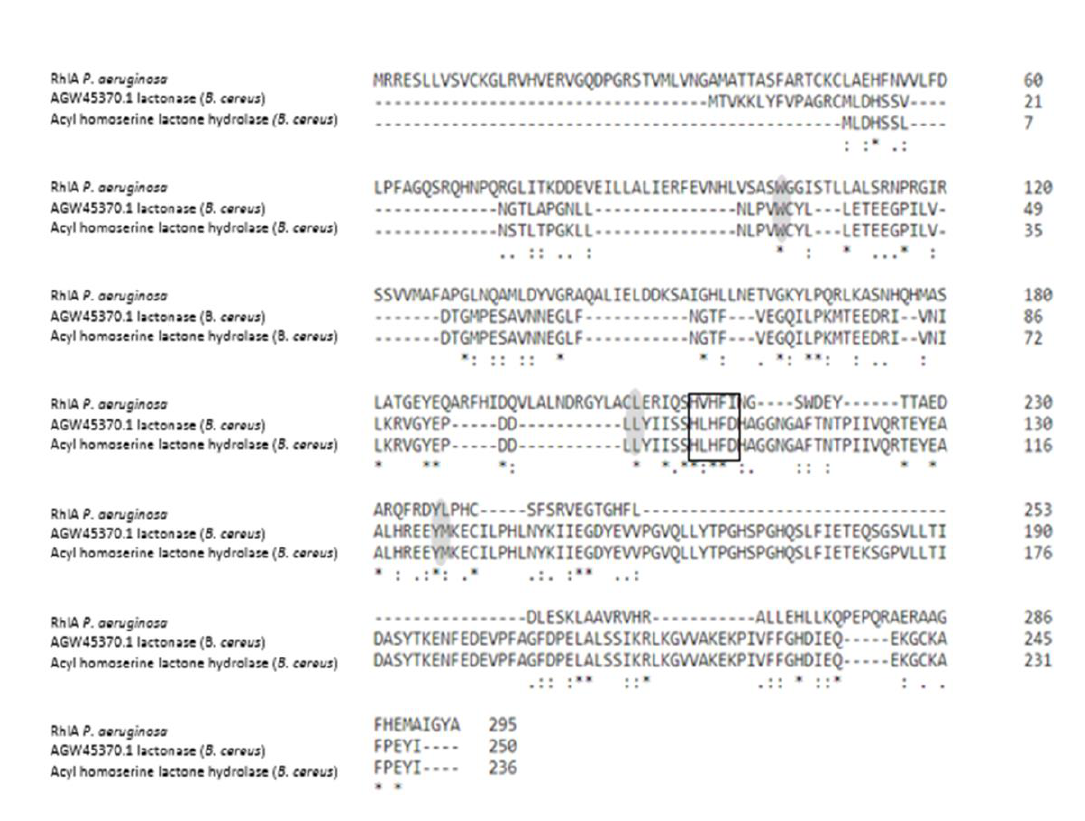
Fig. 4 . Alignment of the amino acid sequence of RhlA (Accession code= WP_003113897.1) with N-acyl homoserine lactonase of Bacillus cereus (accession code= KF254906) and with N-acyl homoserine lactone hydrolase of Bacillus cereus (accession code=KF254908) using Clustal